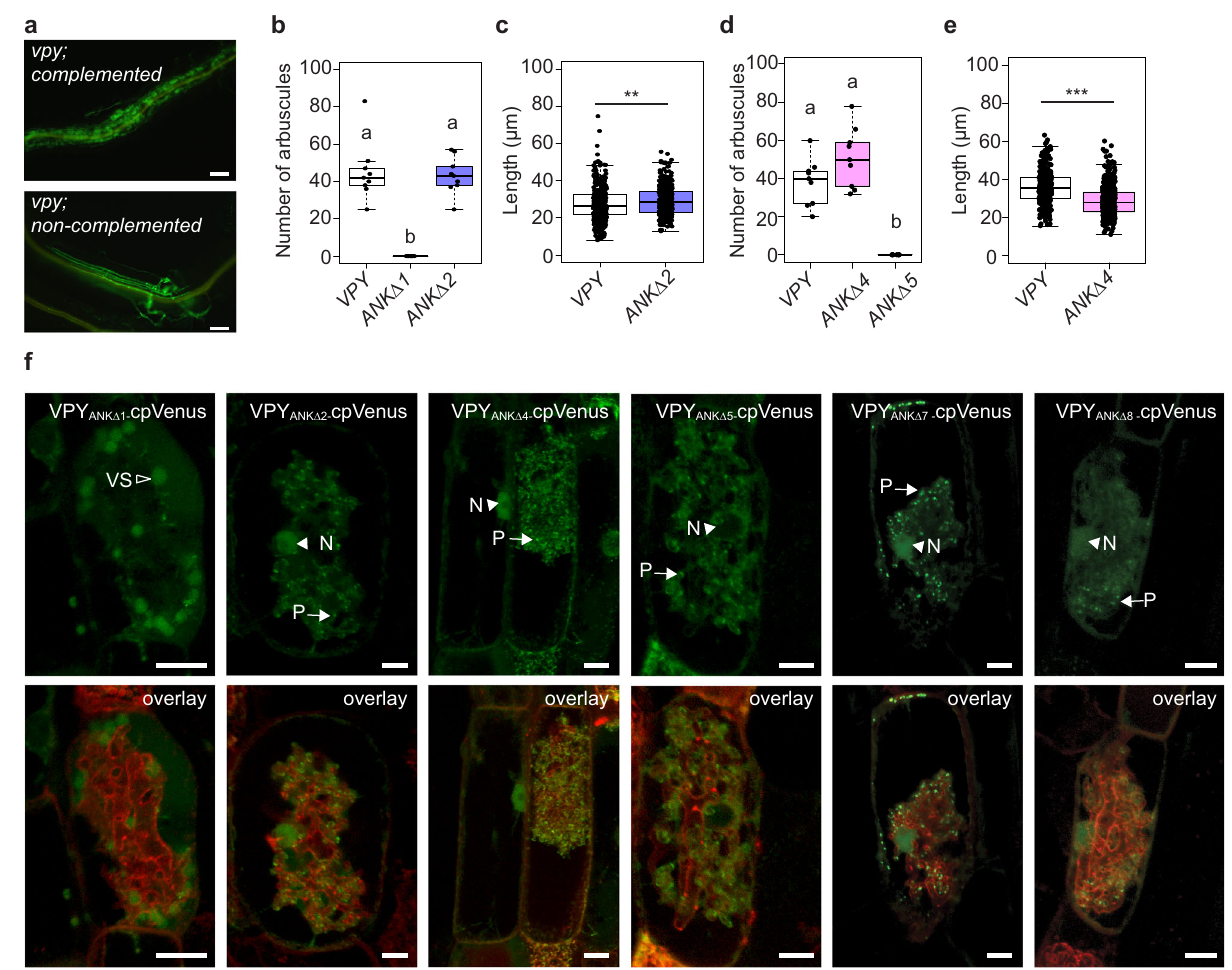
Fig. 3 | Fine scale ankyrin deletion analysis. a – f vpy-4 was transformed with full- length VPY pro :VPY-cpVenus or ankyrin deletion constructs, colonized with D. epi- geae , and harvested 4 weeks post planting. a Representative epi fl uorescence imagesof vpy-4 WGA-AlexaFluor488stainedrootscomplementedwith VPY pro :VPY- cpVenus , or not complemented, as seen for vpy-4 transformed with VPY pro : cpVe- nus . Scale bars are 100 μ m. b Number of arbuscules per infection unit in vpy-4 transformedwithankyrindeletionconstructs.Differentlettersindicatestatistically signi fi cant differences using one-way ANOVA, p <0.05, n =9 infection units, sam- pled from three biological replicates with three infection units per biological replicate. c Arbusculelength of vpy transformed with VPY pro :VPY-cpVenus ( n =406 arbuscules), or VPY pro :VPY ANK Δ 2 -cpVenus ( n =388 arbuscules), sampled from three biological replicates with three infection units per replicate. d Number of arbus- cules per infection unit in vpy-4 transformed with ankyrin deletion constructs. Differentlettersindicatestatisticallysigni fi